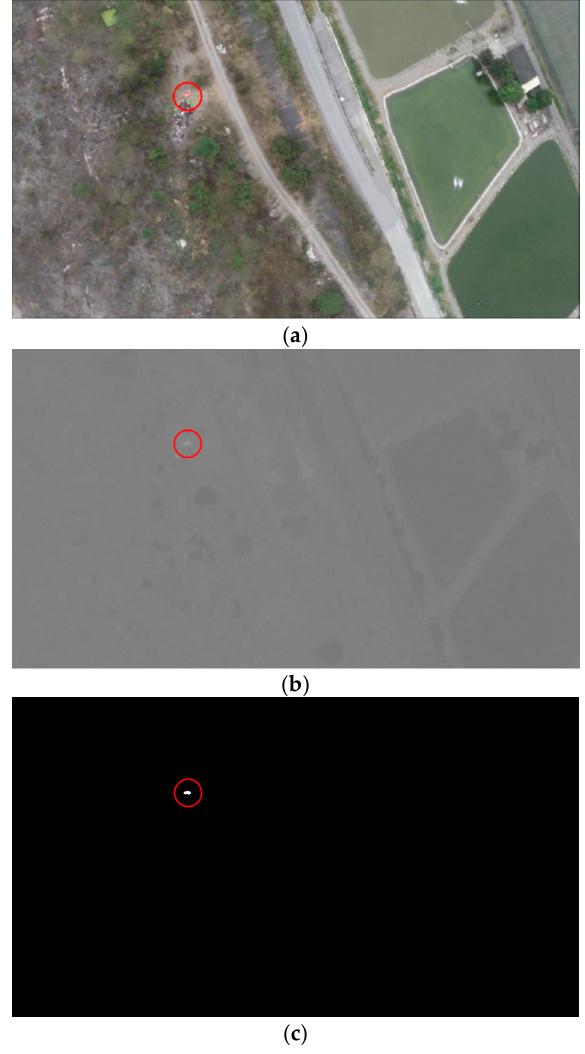
Figure 7. ( a ) The original image with red target in RGB color space; ( b ) the Cr layer of the YCbCr color space and ( c ) the binarized image with threshold.